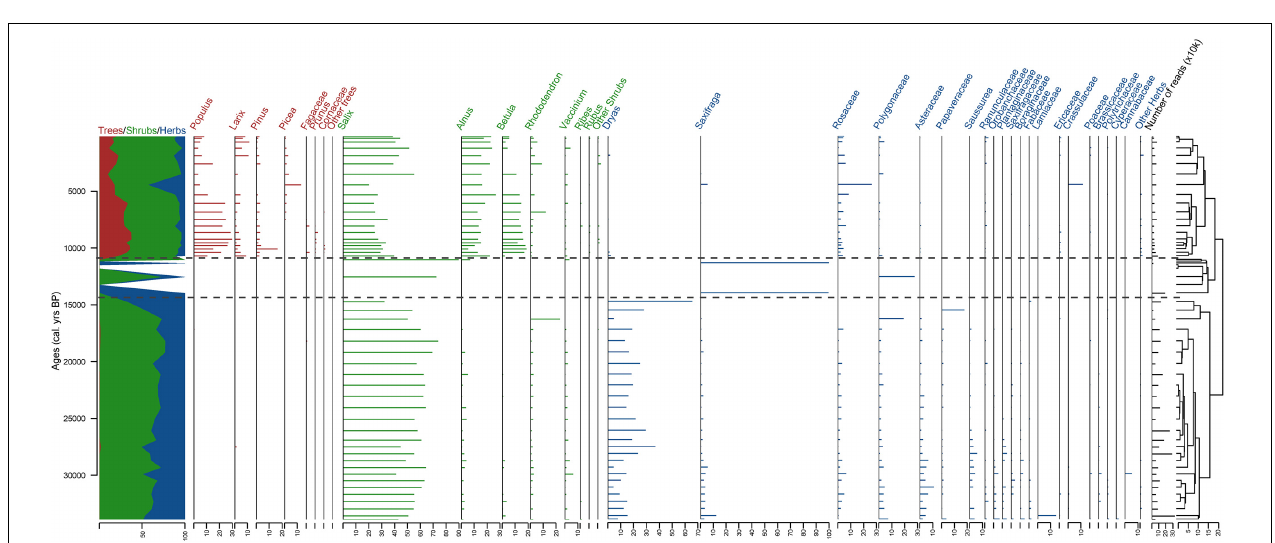
FIGURE 5 | Stratigraphic plot of terrestrial sedaDNA with relative percentages of the taxa in each sample as horizontal bars, ratio of tree/shrub taxa vs herb taxa, and CONISS dendrogram. The taxa are sorted at genus level for trees and shrubs and at family level for herbs. Three sedaDNA zones (DNAZ) are shown, derived from the CONISS analysis. Calibrated ages from the age–depth model are given in calendar years before present (cal yr BP).